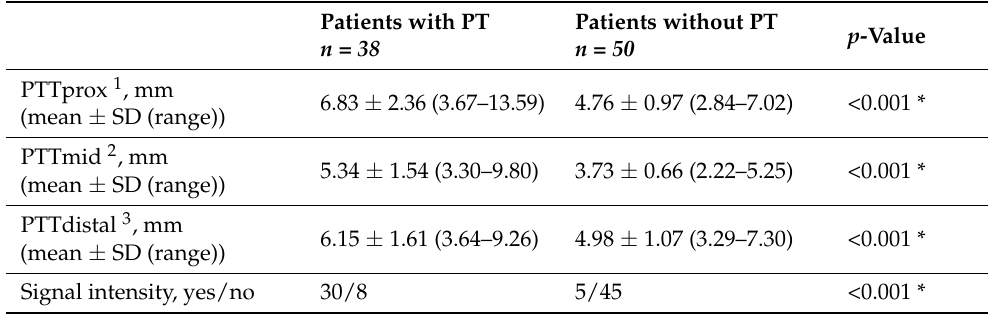
Table 3. Comparison of patellar tendon thickness (PTT) and signal intensity in the MRI of patient versus control